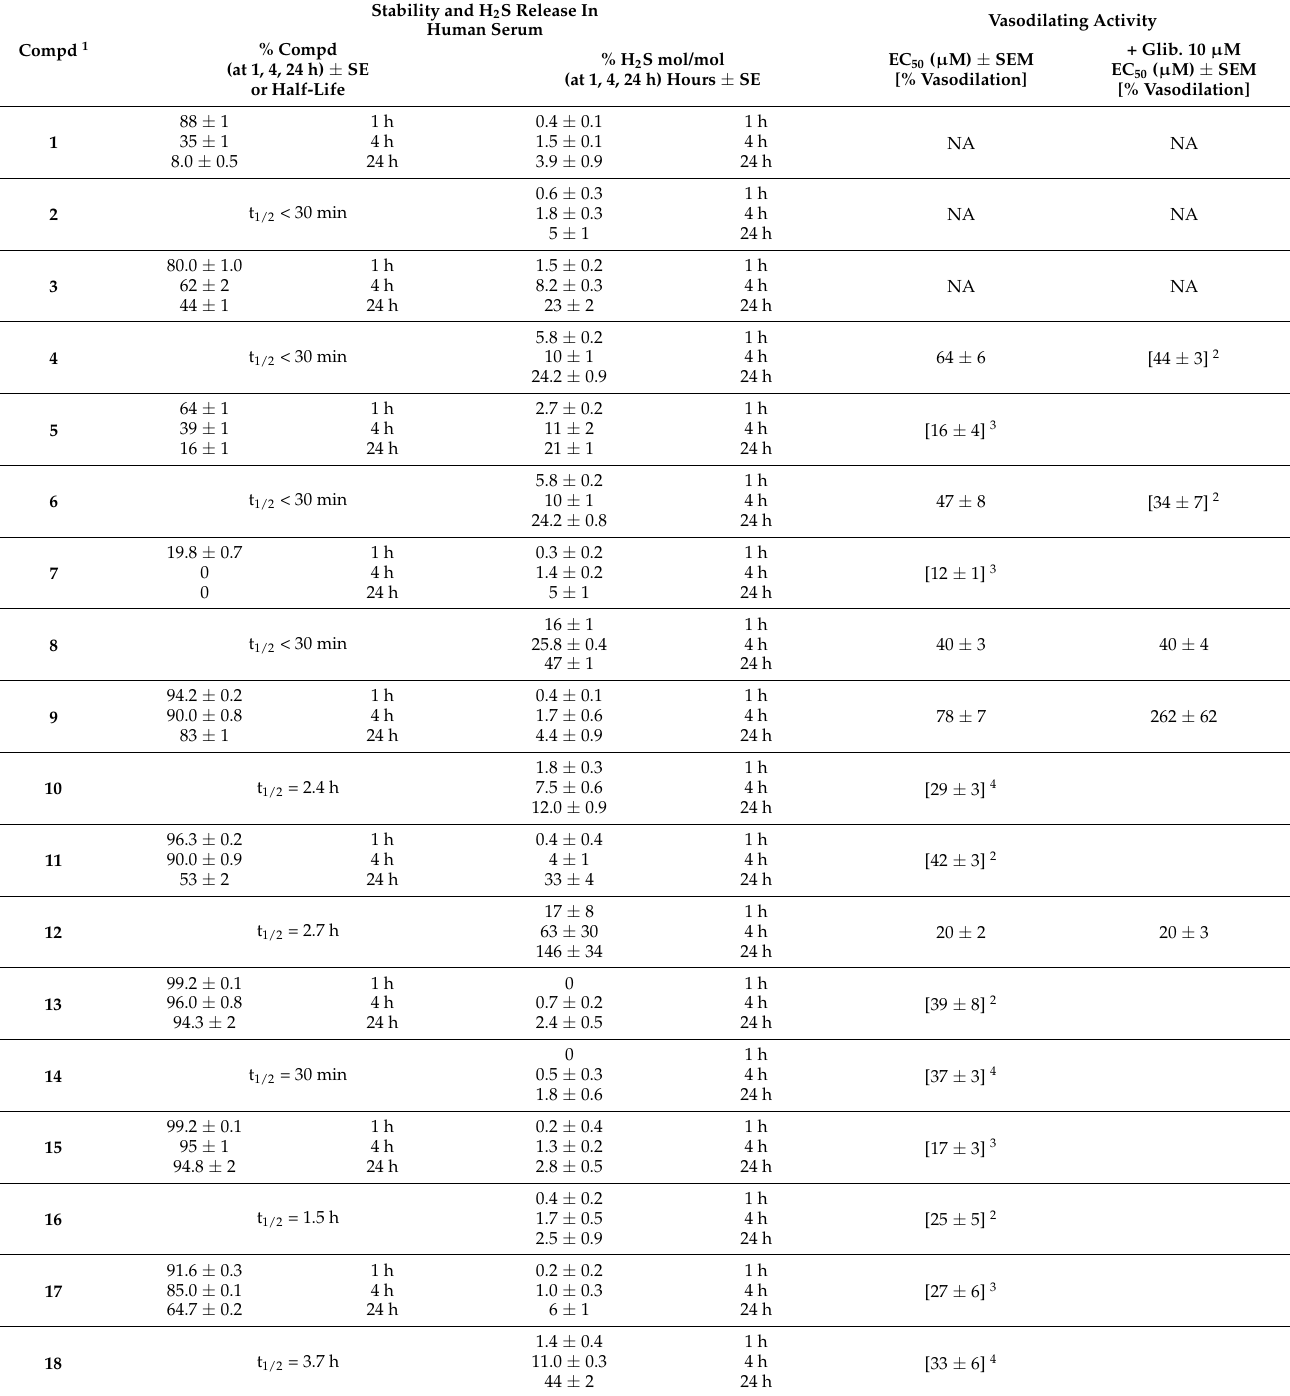
Table 1. Stability, H 2 S release, and vasodilating activity of H 2 S